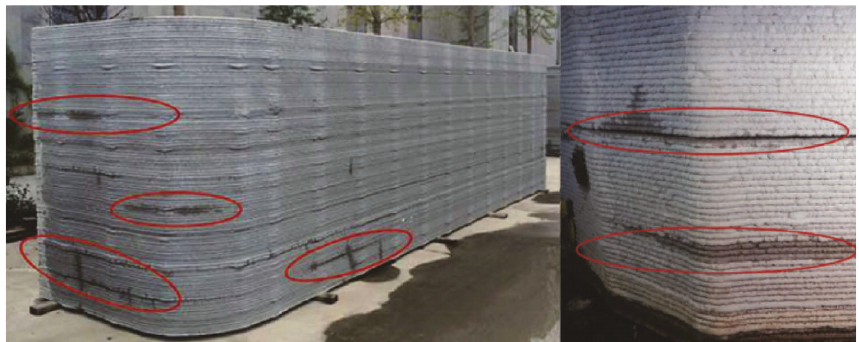
Figure 27: Water seepage caused by weak surface between layers [50].